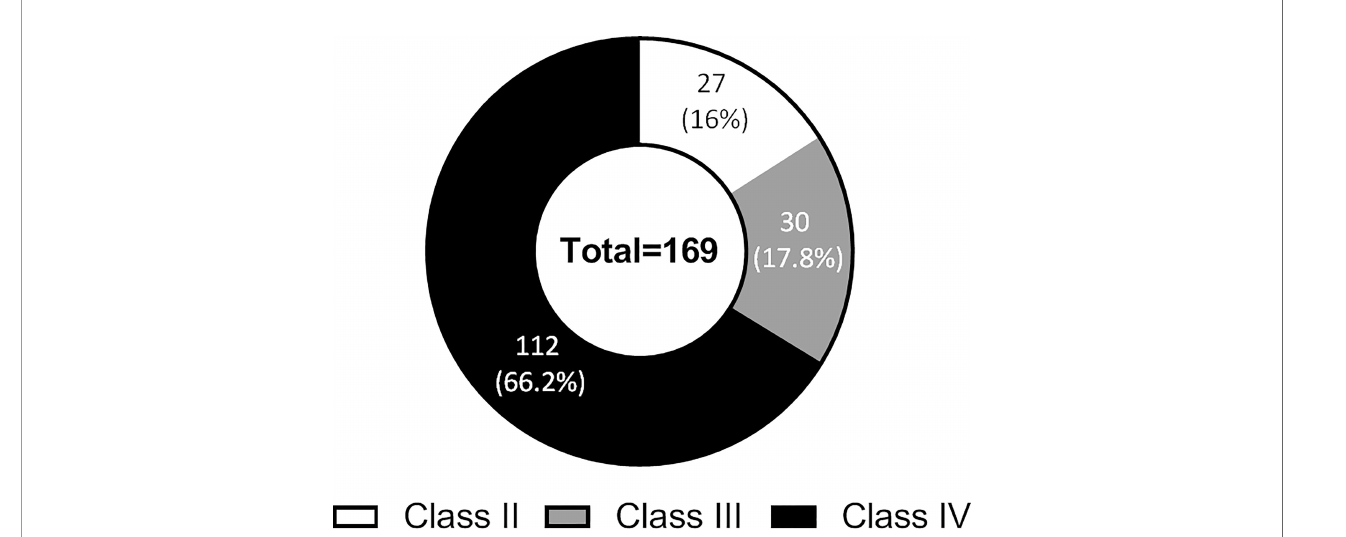
FIGURE 3 | ESCAT class distribution of the mutations found by exome analysis only in genes not contained in small